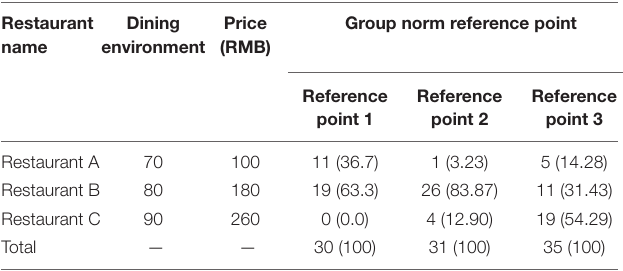
TABLE 5 | Consumer choice statistics of target